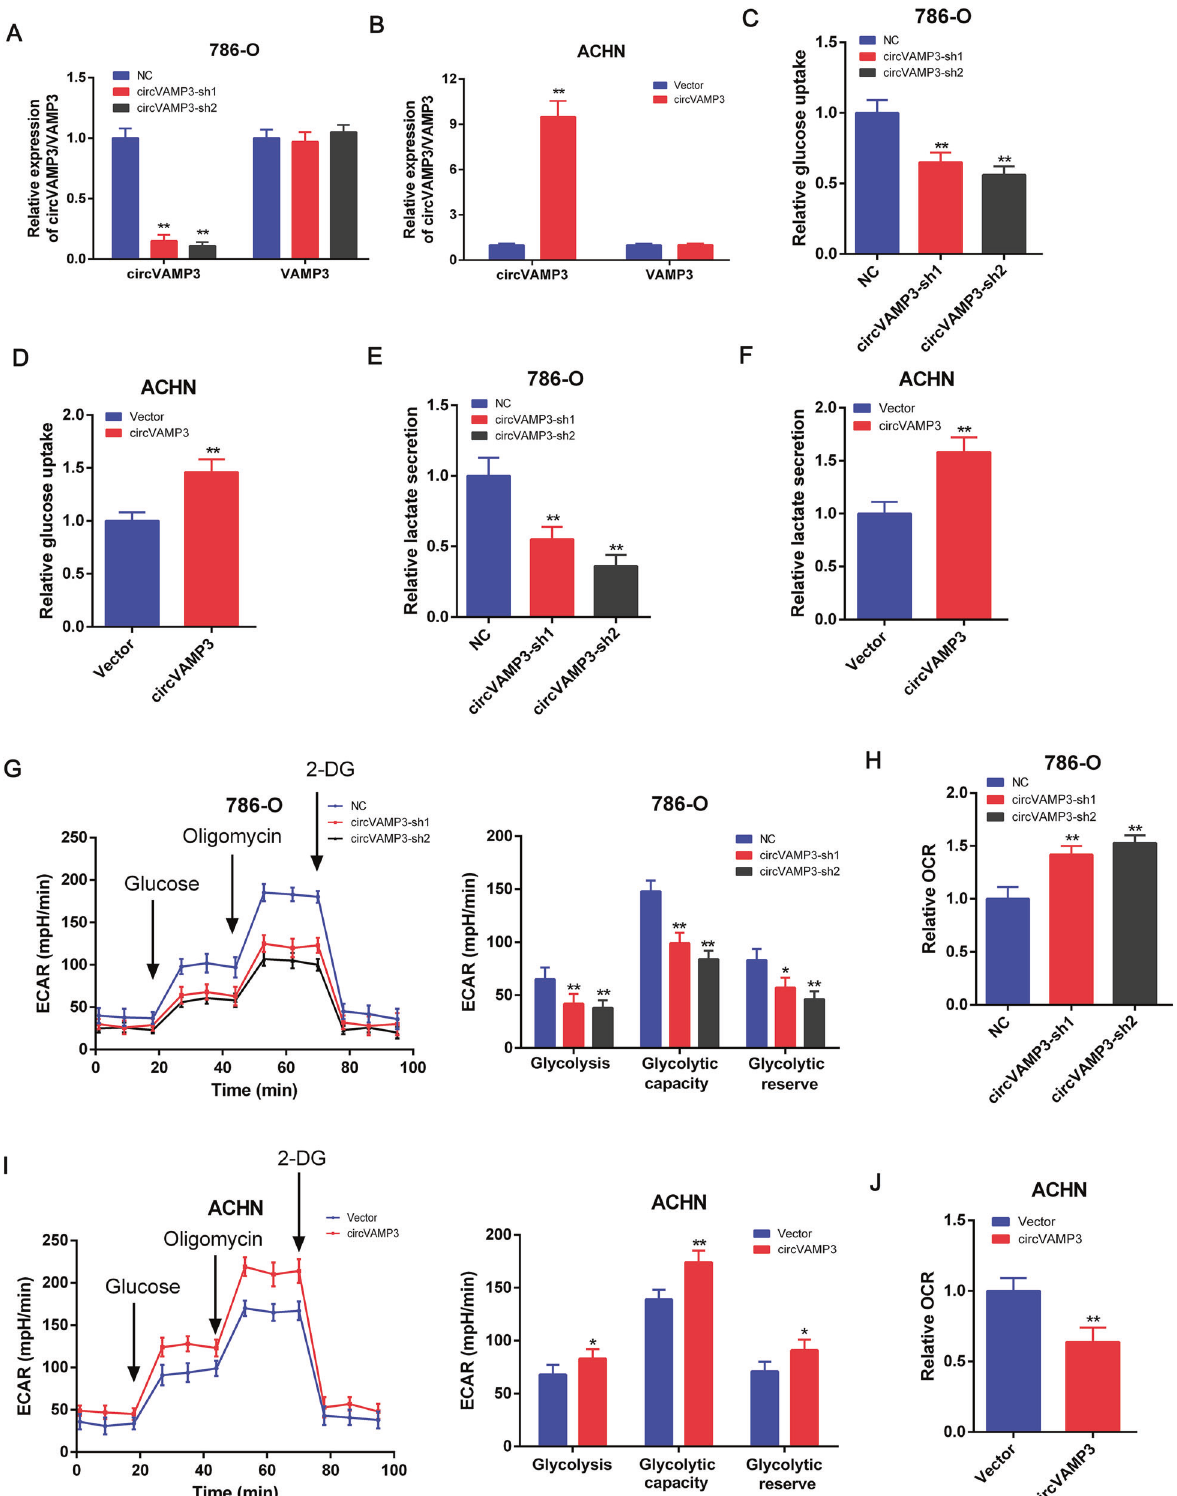
Fig. 3 CircVAMP3 promotes glycolysis in RCC cells. A qRT-PCR measurement of circVAMP3 and VAMP3 mRNA in 786-O cells after stable transfection of circVAMP-sh1/2 or NC. B qRT-PCR analysis of circVAMP3 and VAMP3 mRNA in ACHN cells after stable transfection of circVAMP3 or vector. C Glucose-uptake levels after circVAMP3 knockdown. D Glucose-uptake levels after circVAMP3 overexpression. E Lactate levels after circVAMP3 knockdown. F Lactate levels after circVAMP3 overexpression. G The extracellular acidi fi cation rate (ECAR) was analyzed using the “ Seahorse analyzer ” after circVAMP3 knockdown. The values of glycolysis, glycolysis capacity, and glycolytic reserve were calculated. H The “ relative oxygen consumption rate (OCR) ” was measured using the “ Seahorse analyzer ” in 786-O cells with circVAMP3 knockdown. I ECAR after circVAMP3 overexpression. The values of glycolysis, glycolysis capacity, and glycolytic reserve were calculated. J OCR after circVAMP3 overexpression. The results are presented as the mean ± SD. * P < 0.05; ** P <